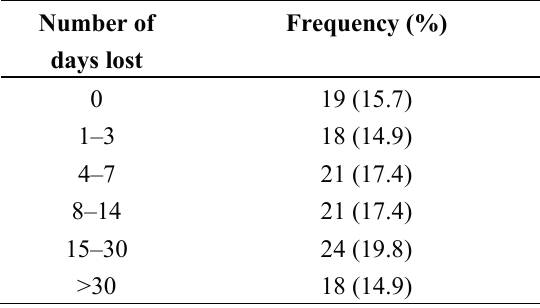
Table 4. Number of days lost following